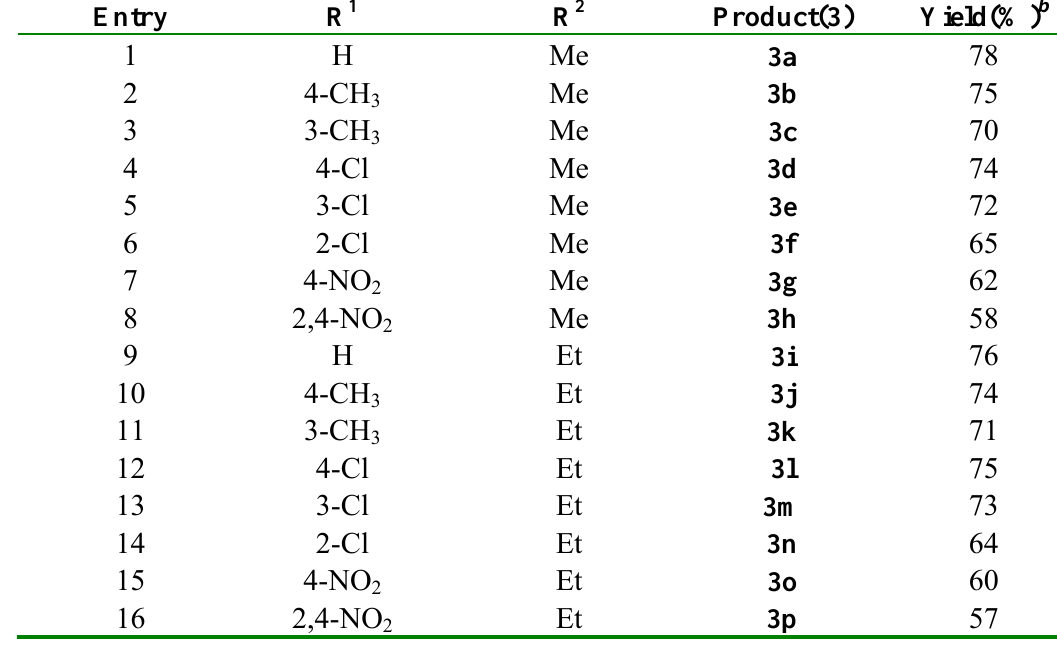
Table 3. Cyclocondensation of substituted o -aminobenzonitrile and β -ketoesters.